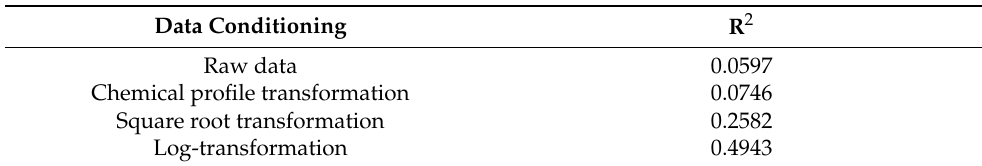
Table 1. Percentage of variance explained by multiple regression between the bacteriological parame- ter E.Coli and the physicochemical